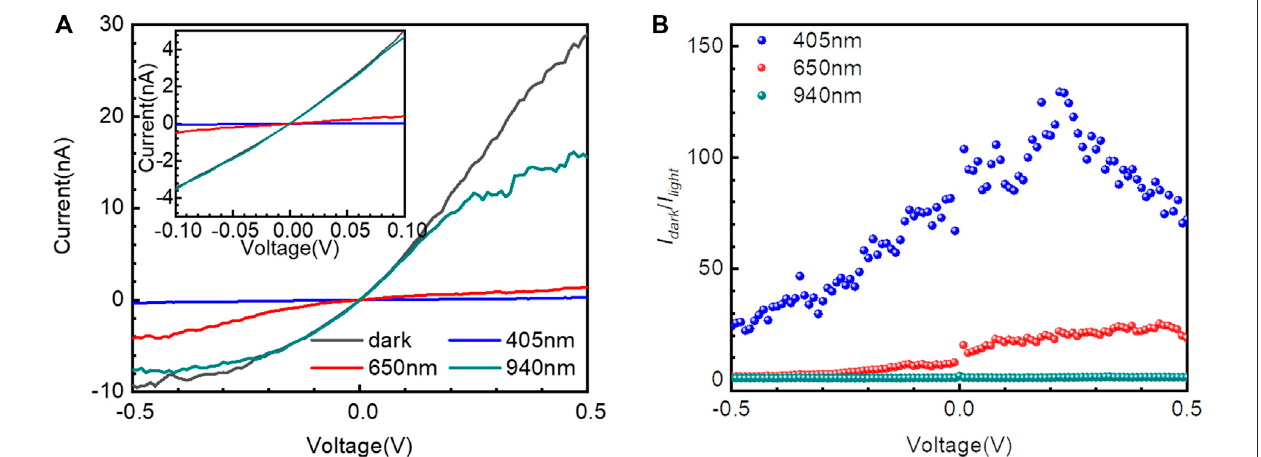
FIGURE2|(A) I – Vcharacteristics oftheInAs NW photodetector deviceunder405 nm (blue), 650 nm (red), and 940 nm (dark green) illumination. Theinsetshows the zoom-in I – V curve swept from − 0.1 to 0.1 V. The light intensity is 500 mW/cm 2 . (B) The dark current to photocurrent ratio as a function of bias voltage under laser incidence with different